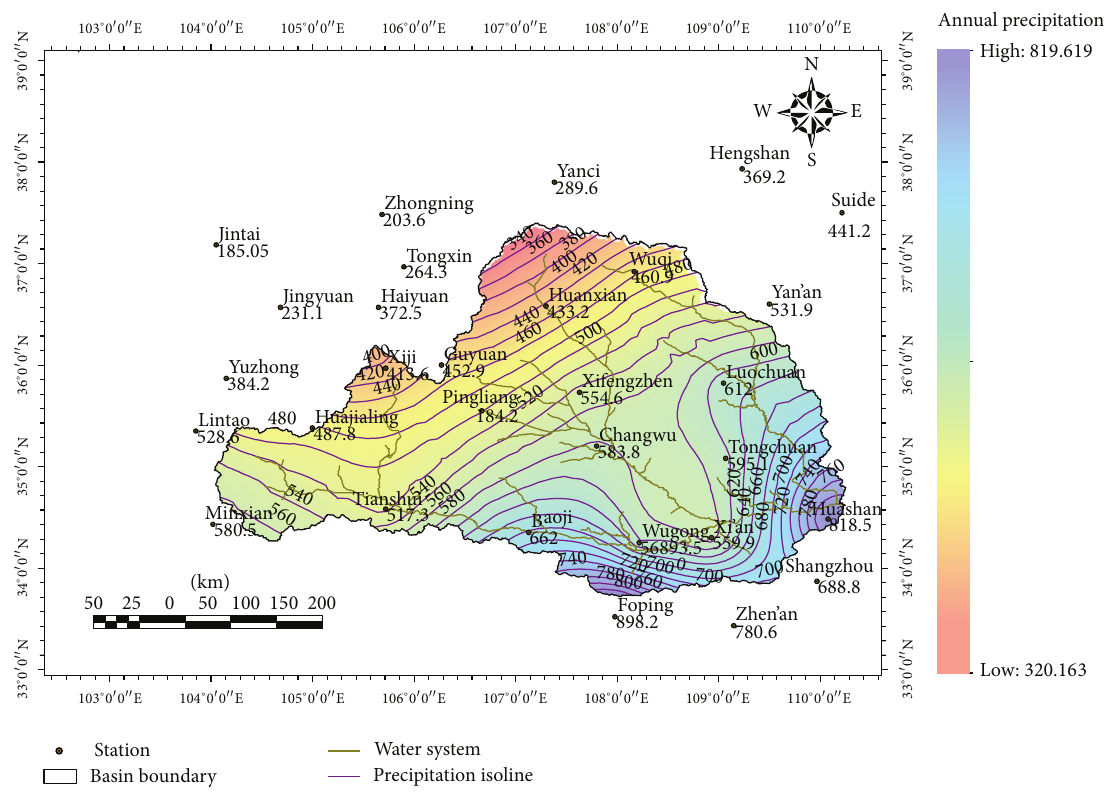
Figure 2: Isohyets showing mean annual precipitation in the Weihe